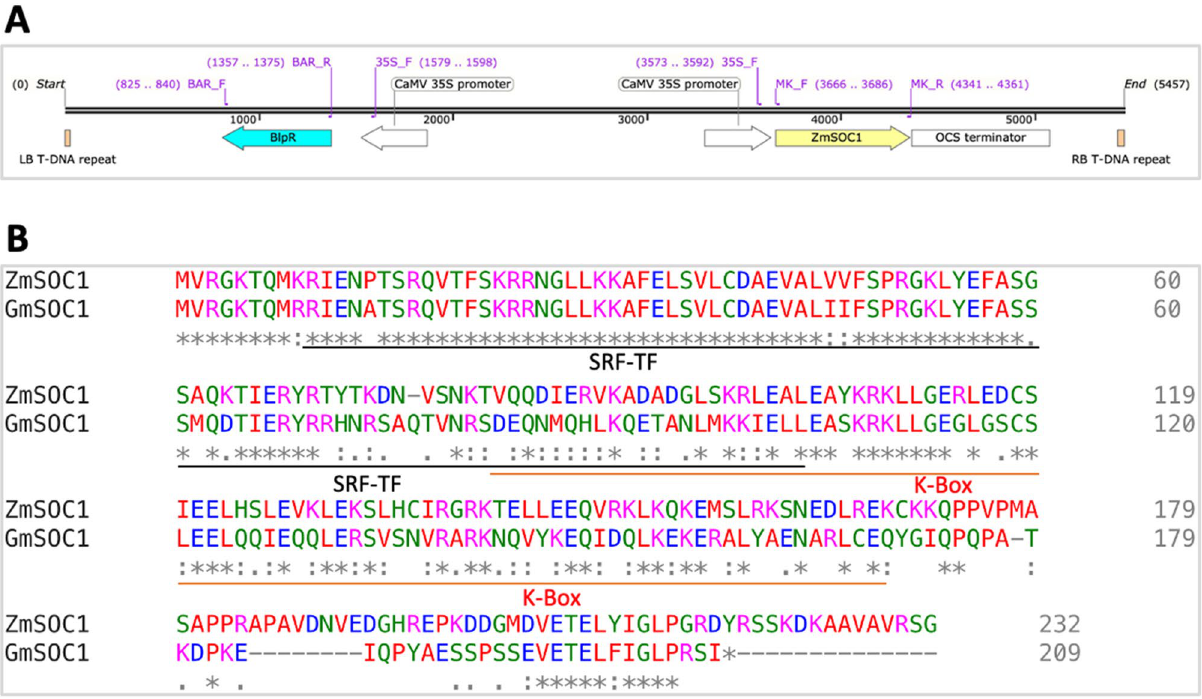
Figure 1. ( A ) Diagram of the T-DNA region of the pTF101.1- ZmSOC1 vector. The primer positions are included in the diagram. LB left border, RB right border. ( B ) Protein sequence alignment of the ZmSOC1 and soybean’s GmSOC1 (iTAK: Glyma.18G224500.2_CDS). The protein sequence of the cloned ZmSOC1 is identical to that derived from either the HQ858775.1 or a part of the NM_001111682.1. GmSOC1 is the same as the sequence detected in the soybean transcriptome reference (cultivar Jack) greenhouse and moved to a secured field under natural environment conditions at East Lansing, Michigan on June 01, 2020. In experiment #2, the seeds were sowed on June 04, 2020 and the plants were growing in the field shared with the plants of experiment #1. Depending on the availability of the seeds, 1–40 seeds per line for all the T 0 line/plant that produced seeds were sowed to evaluate T 1 transgenic plants and to produce T 2 seeds. 150 mg L −1 glufosinate ammonium (GS) was initially used to screen herbicide resistant transgenic plants by painting a half of a leaf along the midvein for each of the T 1 seedlings. GS-resistant plants were transferred to one-gallon pots (20 cm diameter × 16 cm height). DNA from the GS-resistant plants was isolated for PCR analy- sis of the transgenes. For phenotypic evaluation, the data collected for each plant included: (1) Date of seed germination; (2) Date of the appearance of first flower; (3) Node position where the first flower appeared; (4) Date of the first pod set; (5) Plant height measured and branch number and pod number counted at 141 for experiment #1 and 110 day for experiment #2 after sowing; (6) Pictures taken at different developmental stages; and (7) Seed protein, oil, and fiber contents were measured using a Grain Analyser (Infratec™ 1241, FOSS Analytical AB, Denmark). Fatty acids were extracted as described by Bubeck et al. from two seeds of each plant 40 . Fatty acid composition was determined by gas chromatography.